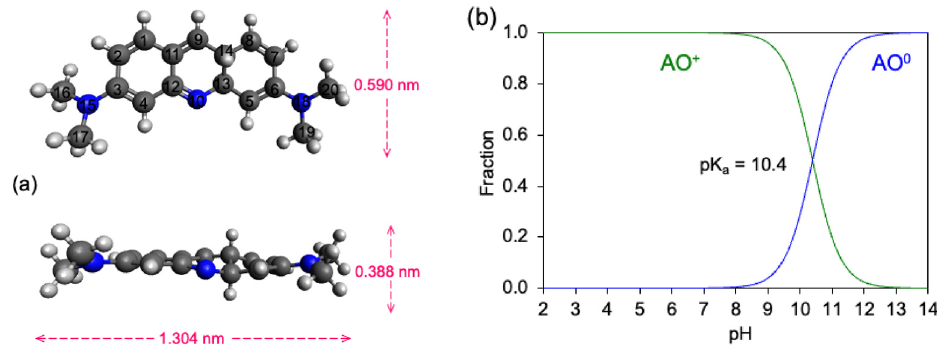
Figure 1. Molecular structure of AO with its dimensions ( a ) and its pH speciation diagram ( b ).